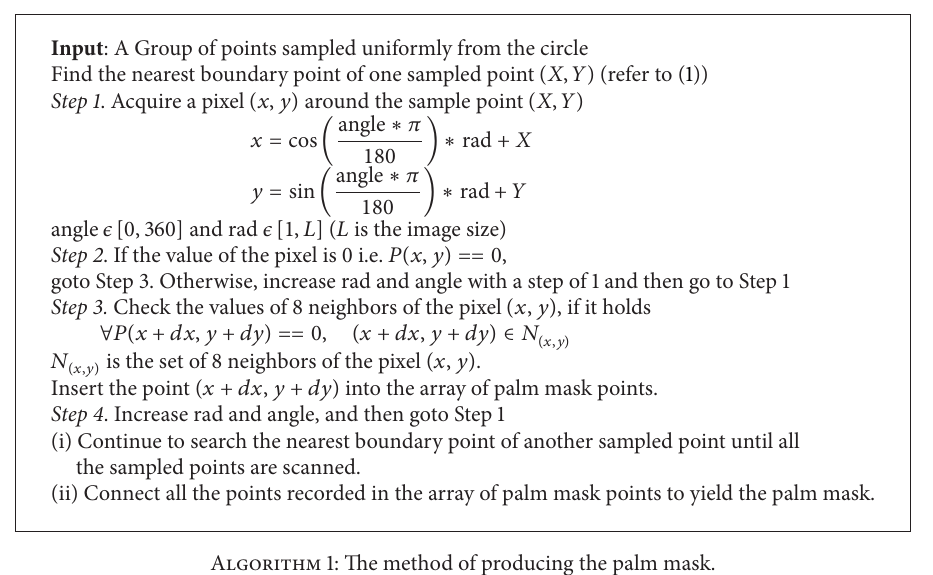
Algorithm 1: The method of producing the palm mask.